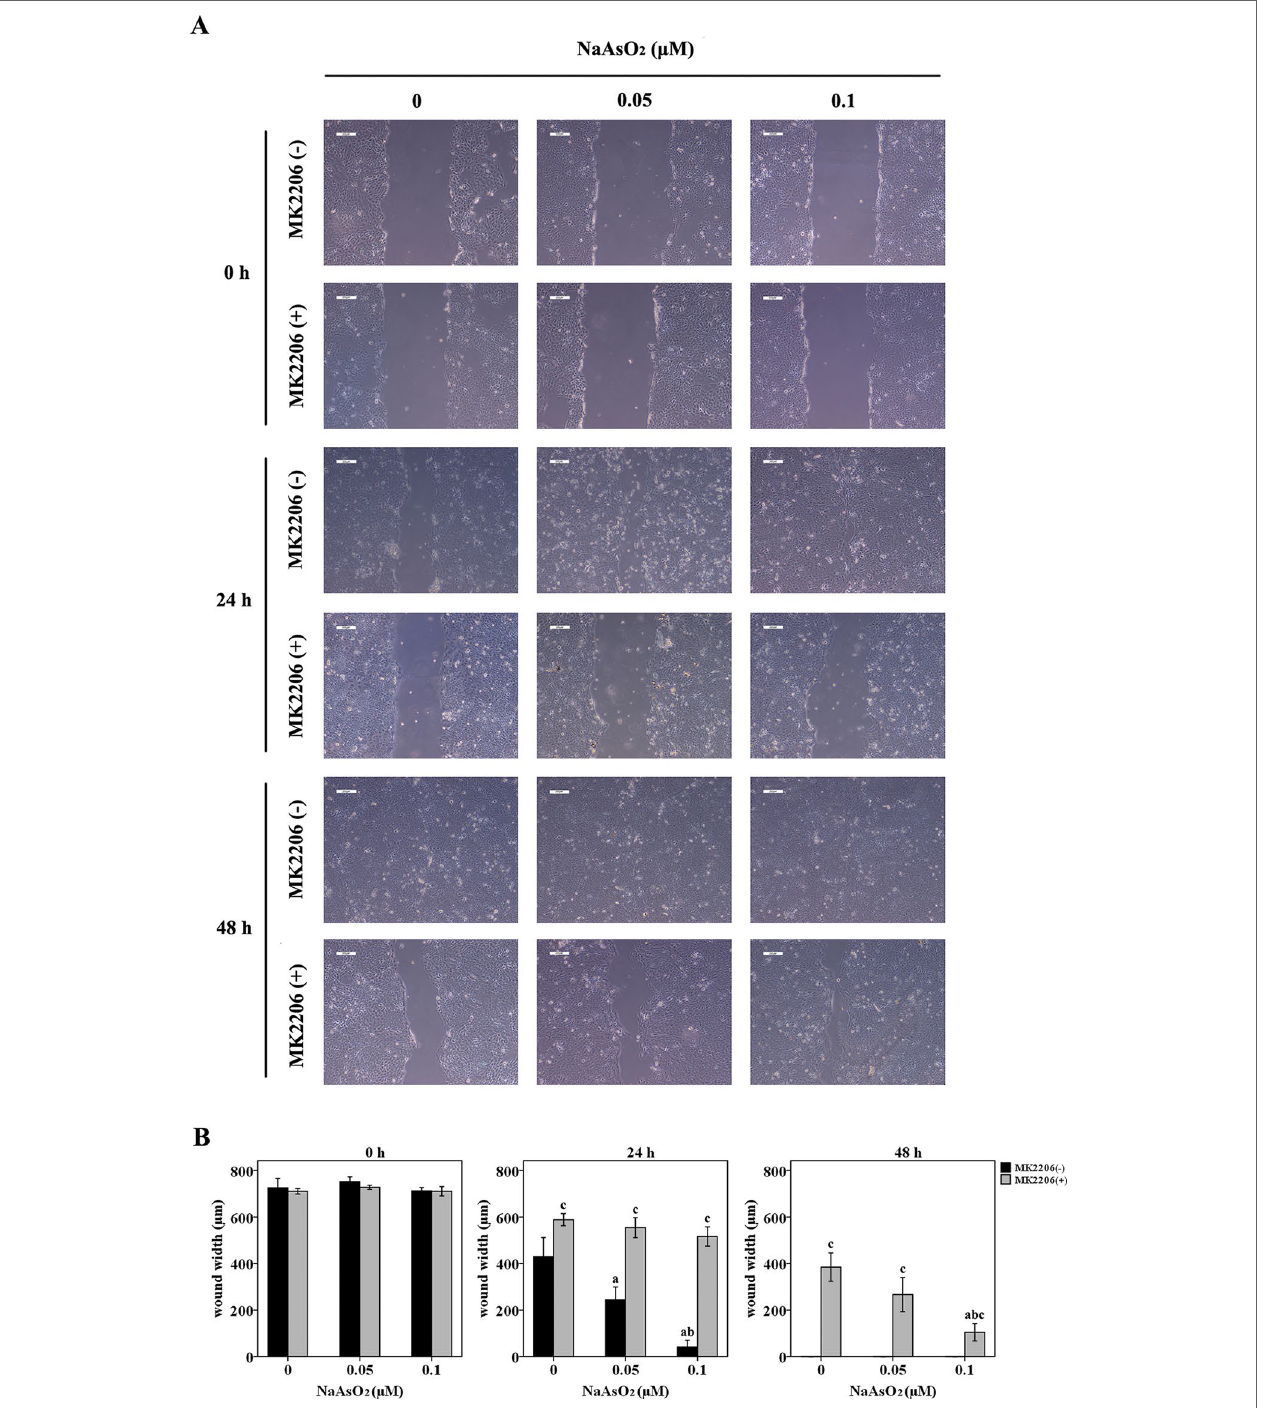
FIGURE 2 | Repeated low-dose NaAsO 2 exposure increased the wound closure speed of HaCat cells. Cells were seeded into 6-well plates. The cell monolayers were scratched using a 200 μl pipette tip to create a wound. Half of the cells were treated with MK2206 (10 μmol/L). DMSO was added into the other half of the cells. Wound width was monitored over time by microscopy and photographed immediately at the time point of 0, 24 and 48 h after MK2206 treatment. (A) Images are the representative photos of three separate experiments. (B) Quantitation of wound width ( n = 3). NaAsO 2 exposure increased the wound closure speed, no matter in the presence or absence of MK2206. Although wound closure was inhibited by the treatment of MK2206, NaAsO 2 exposed cells showed higher wound-healing capability than that of the control cells. Significant difference was defined as p less than 0.05. a, vs. the corresponding 0 μM group; b, vs. the corresponding 0.05 μM group; c, vs. the MK2206(-) group of the same NaAsO 2